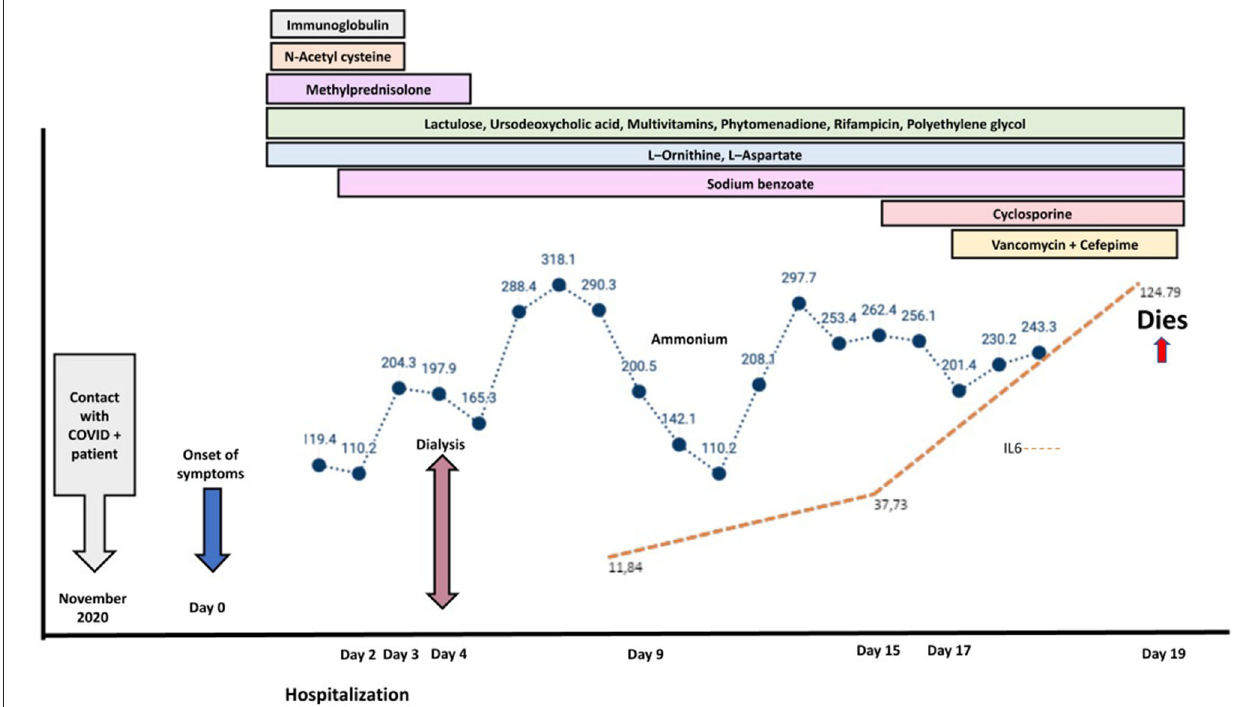
Frontiers in Pediatrics |